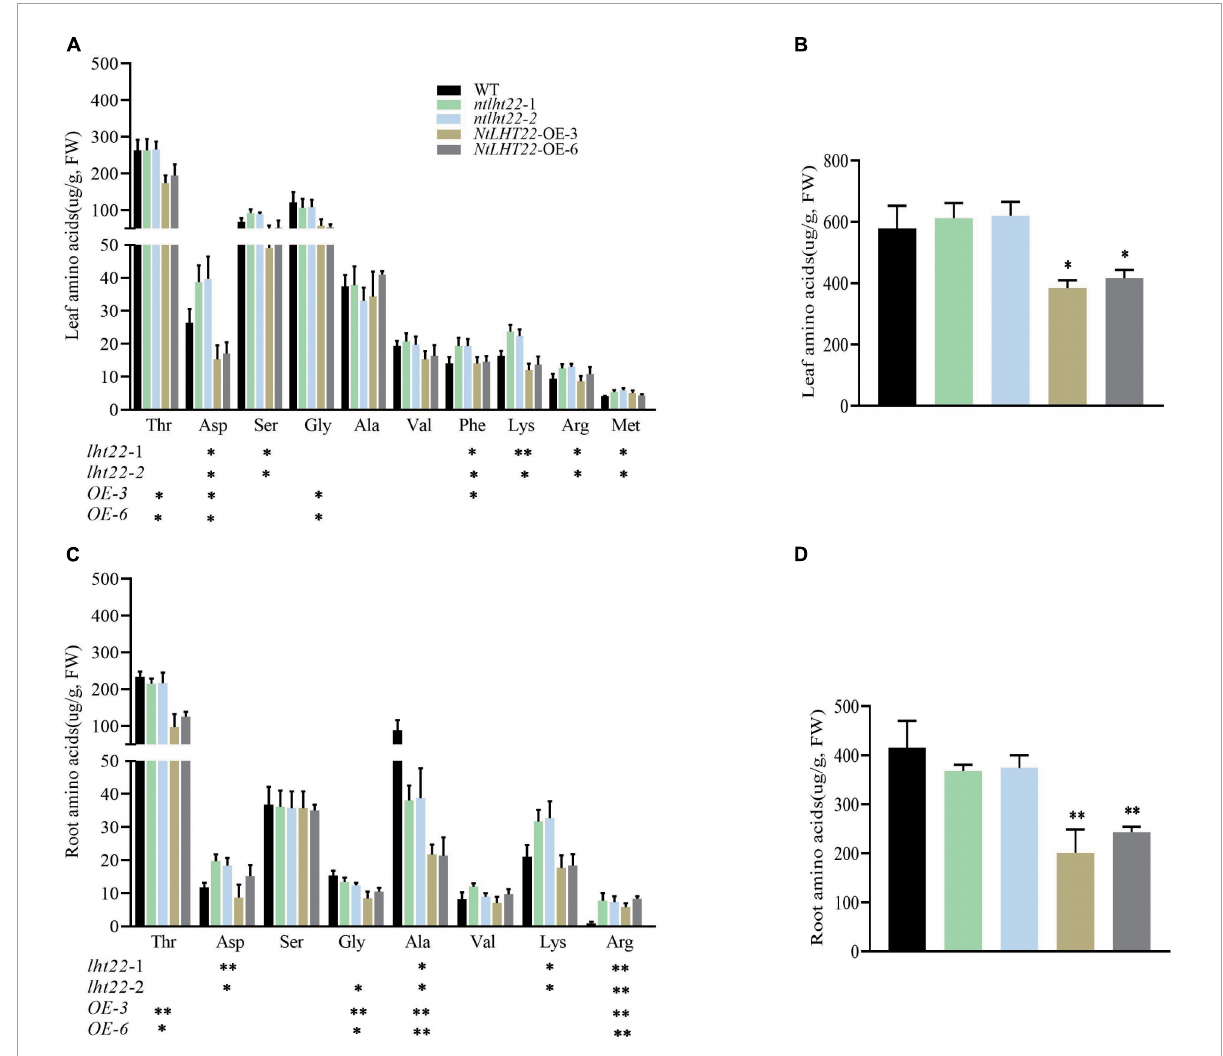
FIGURE9 Analysis of amino acids levels of NtLHT22 overexpression, knock out, and wild-type plants. (A,B) Individual and total amino acids content in leaf. (C,D) Individual and total amino acids content in roots. FW, fresh weight. The data were presented as means ± SDs ( n = 3). Significant differences was detected using Student’s t -test. ∗ P < 0.05, ∗∗ P <